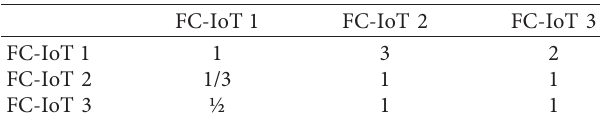
Table 7: Architecture 2.